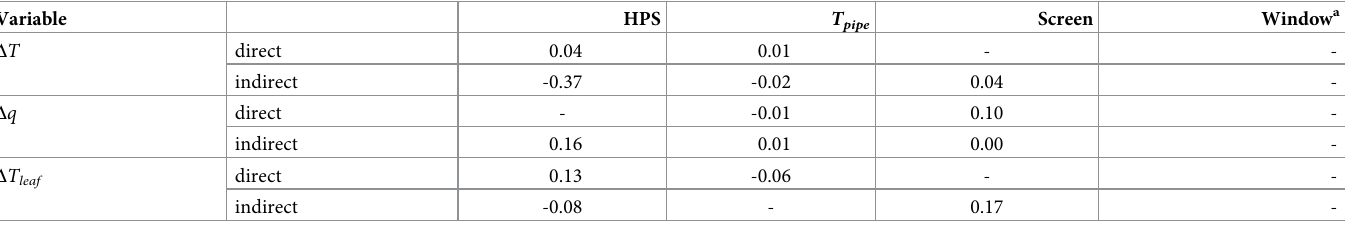
Table 2. Absolute direct and indirect effects of climate control measures on the difference between ambient and canopy air temperature, Δ T , and absolute humidity, Δ q , and on the difference between canopy air and leaf temperature, Δ T leaf . Values are obtained by multiplying the coefficients in a path and adding the multiplied coeffi- cients from different paths. Note that negative values for Δ T mean a larger negative difference.